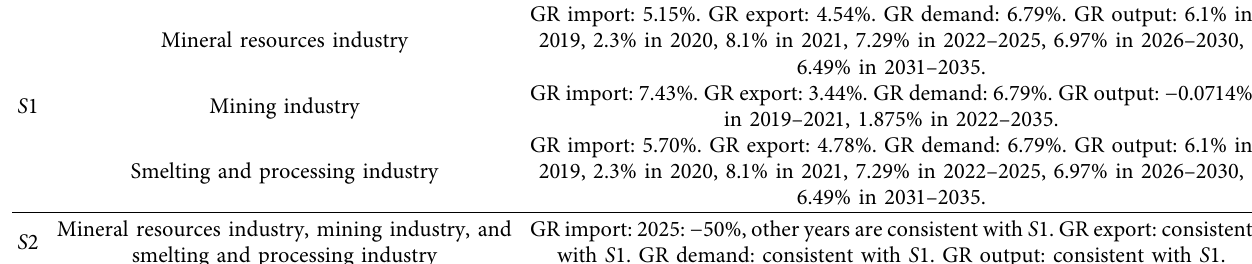
Table 2: Parameters under steady economic development and supply chain crisis from 2019 to 2035.